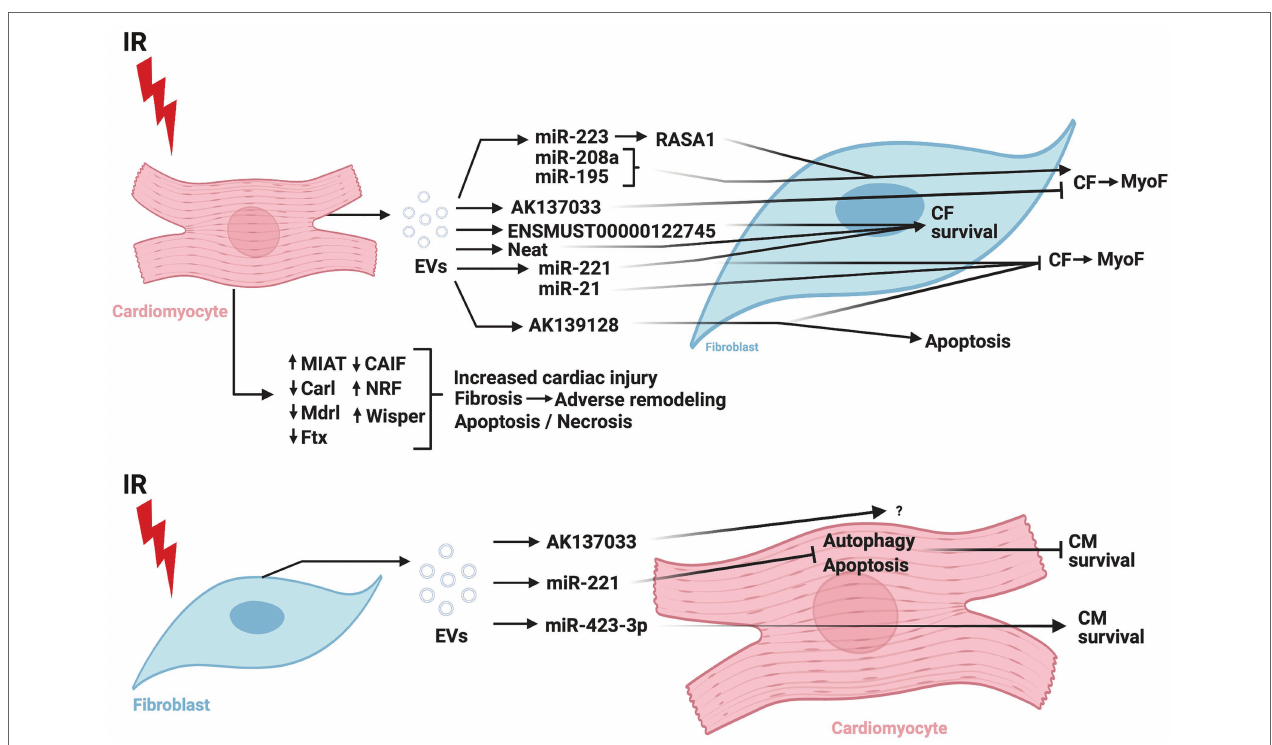
FIGURE 4 | Role of non-coding RNAs in cardiomyocyte-cardiac fibroblast crosstalk in ischemia/reperfusion injury. IR, ischemia/reperfusion; EV, extracellular vesicles; CM, cardiomyocytes; CF, cardiac fibroblasts; MyoF, myofibroblasts; MIAT, myocardial infarction-associated transcript; Carl, cardiac apoptosis-related lncRNA; Mdrl, mitochondrial dynamic related lncRNA; Ftx, five prime to Xist; CAIF, cardiac autophagy inhibitory factor; NRF, necrosis-related factor; Wisper, Wisp2 super-enhancer-associated RNA; miR, micro-RNA; RASA1, RAS p21 protein activator 1. The figure was created using